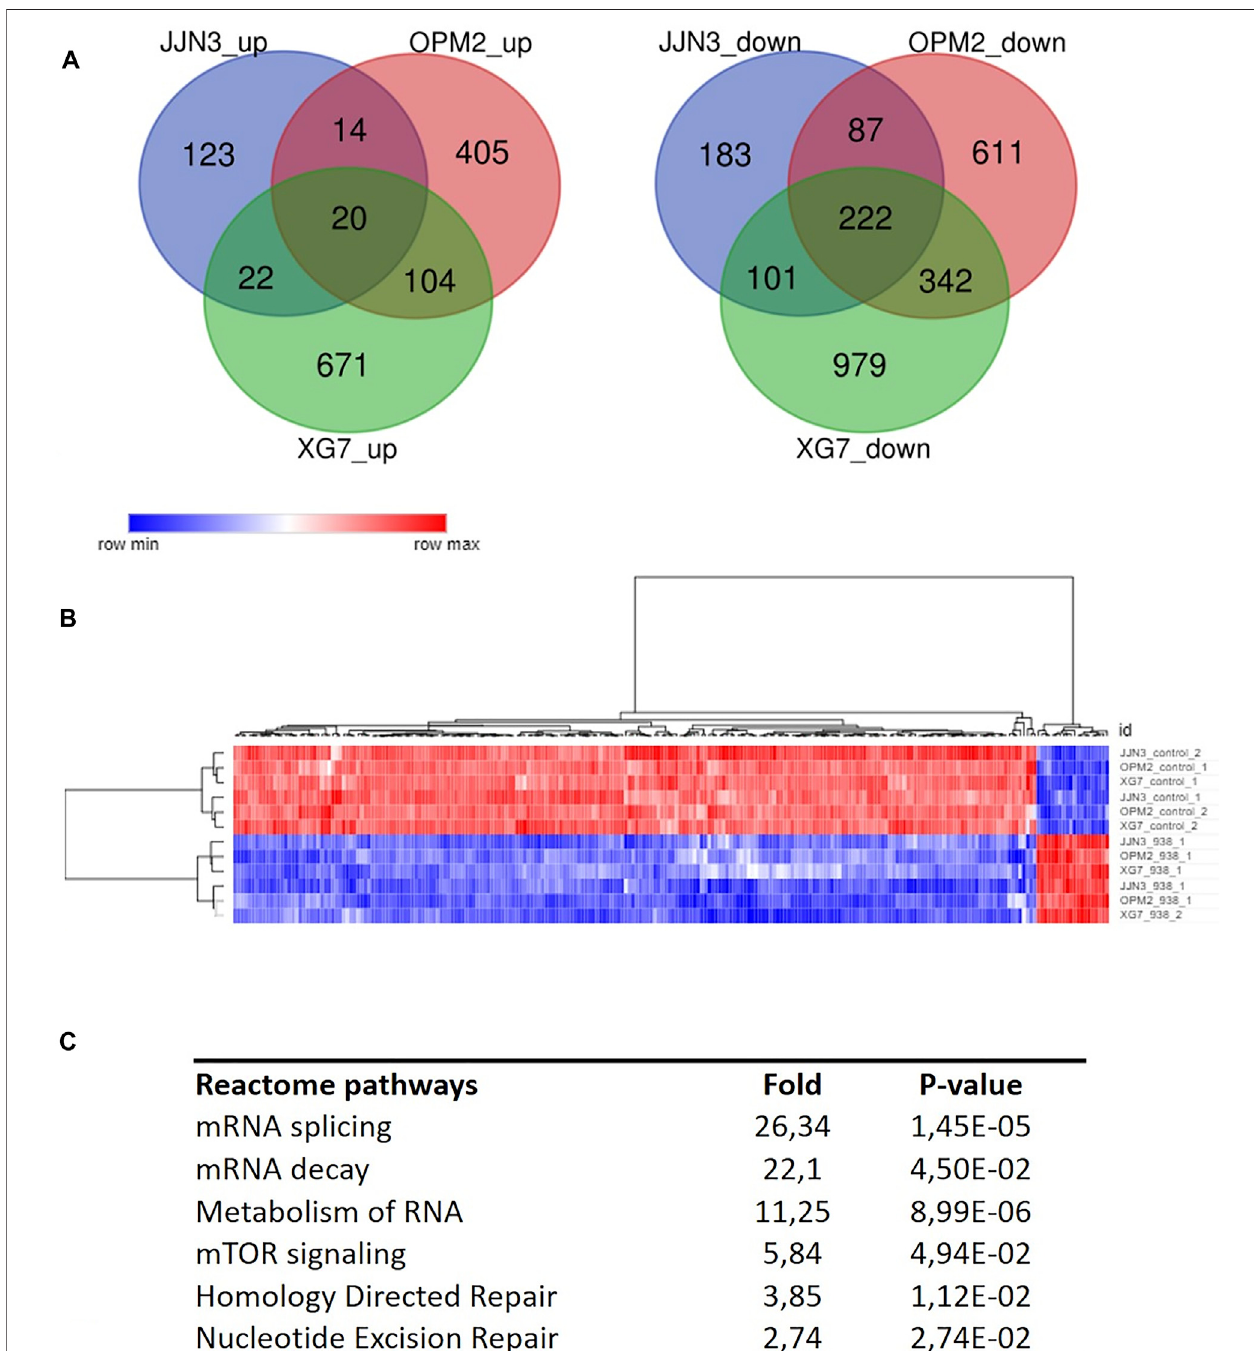
FIGURE 2 | (A) : Deregulated genes after PRMT5 inhibition were identi fi ed using RNA-seq and analysed for JJN3, OPM2 and XG7 cells separately due to possible cell type speci fi c events. Venn diagram analysis shows the presence of a speci fi c set of common up- (left) or downregulated (right) genes per cell line type ( n = 2 × 2 per celltype/treatment). (B) :Unsupervised clusteringofanalysedsamplesused forRNA-seq basedoncommon deregulatedgenes( n =242), clearlysegregatingaccording to treatment type. (C) : Overview of reactome pathway analysis output (selected pathways are shown) with fold changes and p -values per pathway, after multiple testing